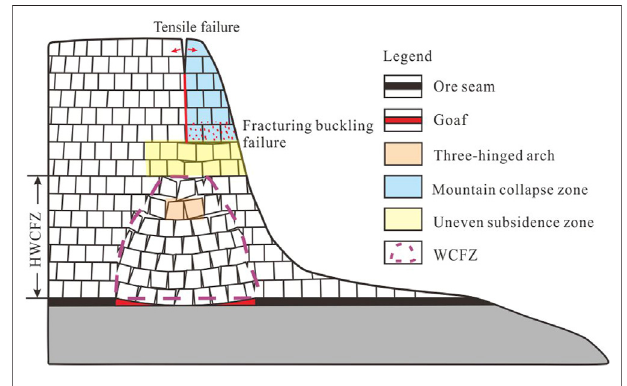
FIGURE 13 | Typical slope instability model in the southwest carbonate mountainous